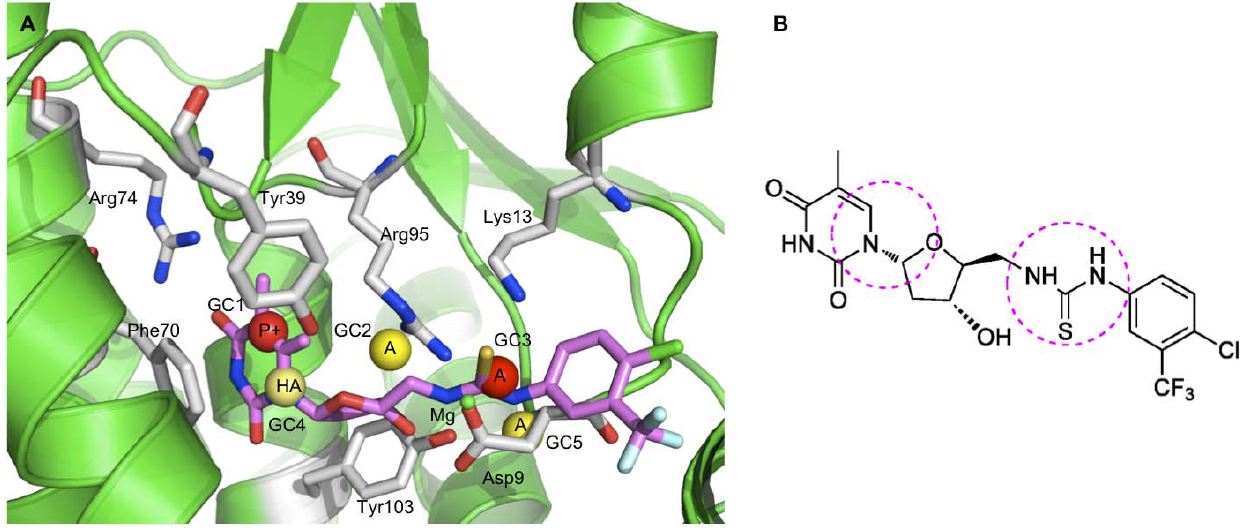
Figure 3. ( A ) Representation of the RI-4D-QSAR postulated “bioactive” conformation of the most potent inhibitor ( ATT14 ) of the training set docked at the TMPKmt active site. Only the main interacting residues in the pocket of the binding site are shown in stick model representations (carbon atoms in gray). The inhibitor ATT14 is presented as stick models (carbon atoms in magenta). The GCODs of the best 4D-QSAR model are also shown in the active site of the crystal structure of TMPKmt, represented as spheres of 1 Å radius. Inhibition-enhancing and inhibition diminishing GCODs are shown, respectively, as yellow and red spheres. The IPEs atom types are as follows: A = any; NP = nonpolar; HA = hydrogen bond acceptor. ( B ) Chemical structure of ATT14 , showing the main regions that contain pharmacophore sites, such as the sugar-pyrimidine ring structure and the 5 ′ -arylthiourea moiety, which further can be explored to identify better inhibitors of